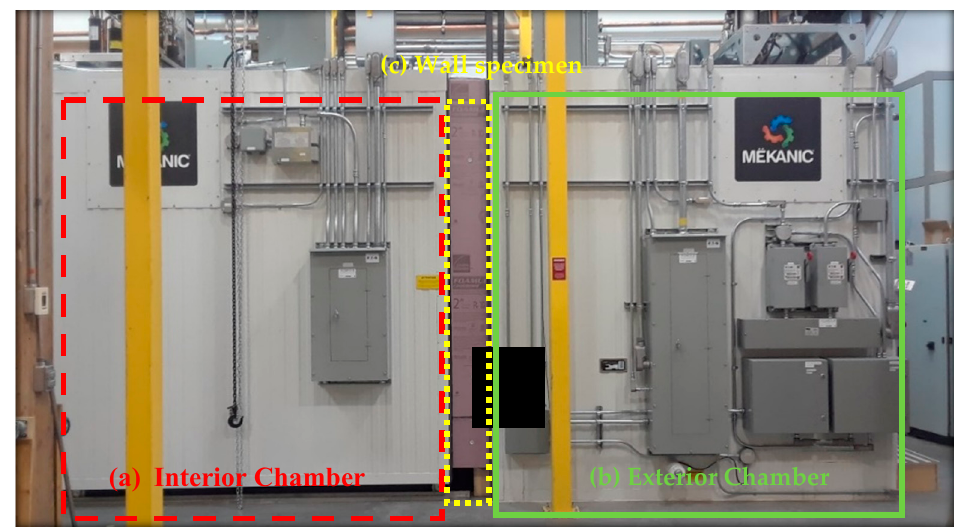
Figure 2. The experimental setup comprising ( a ) a climate chamber reproducing normal indoor conditions, ( b ) a climate chamber reproducing outdoor winter conditions and ( c ) a wall specimen that was covered with insulation to limit the heat transfer to the outside of the laboratory.